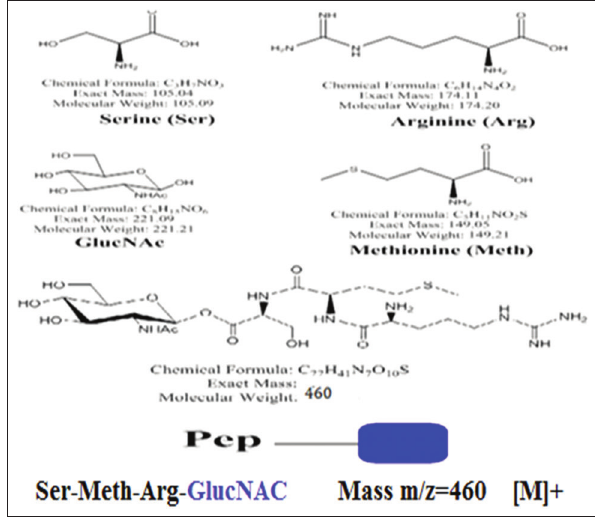
Figure-4: Proposed structures of O-glycans from isolated GlcNAc glycoprotein fraction; using mass